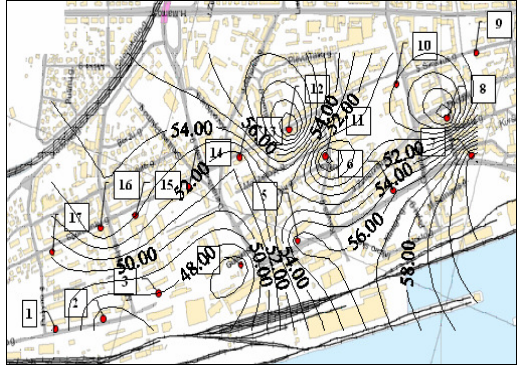
Fig. 6. Noise spread in the northern part of Klaipėda city in the daytime in autumn